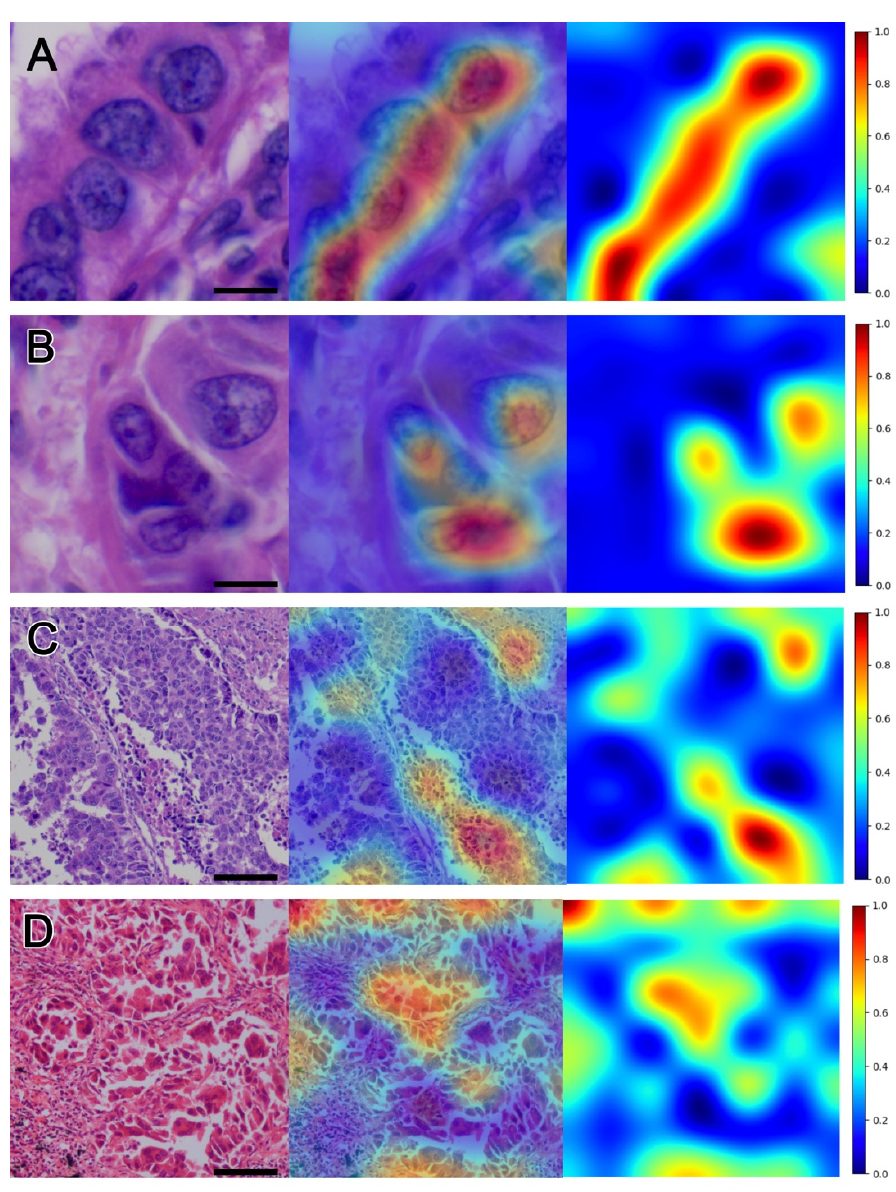
Figure 4. Gradient-weighted class activation mapping (Grad-CAM) heatmaps of pathology images (100 × and 400 × ). Grad-CAM generated heatmaps to identify the histological features that may be associated with a high probability of recurrence. In the high-power images, atypical tumor nuclei ( A , B ), tumor necrosis ( C ), and discohesive tumor cells ( D ) were identified using Grad-CAM as associated with a high probability of recurrence. Scale bar length 10 µ m ( A , B ) and 100 µ m ( C , D ).